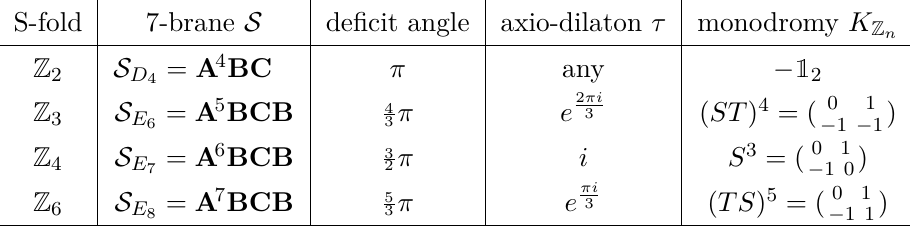
Table 3 . The characteristics of the 7-branes for the Z n